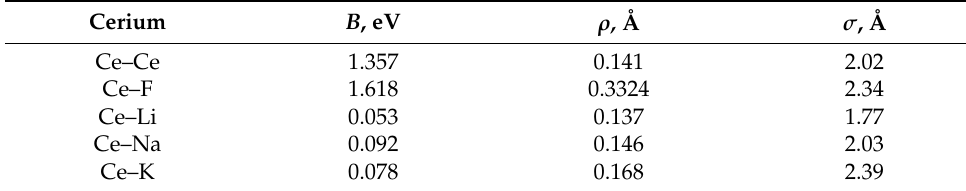
Table 1. Parameters for interaction of Ce with other components of molten salt.